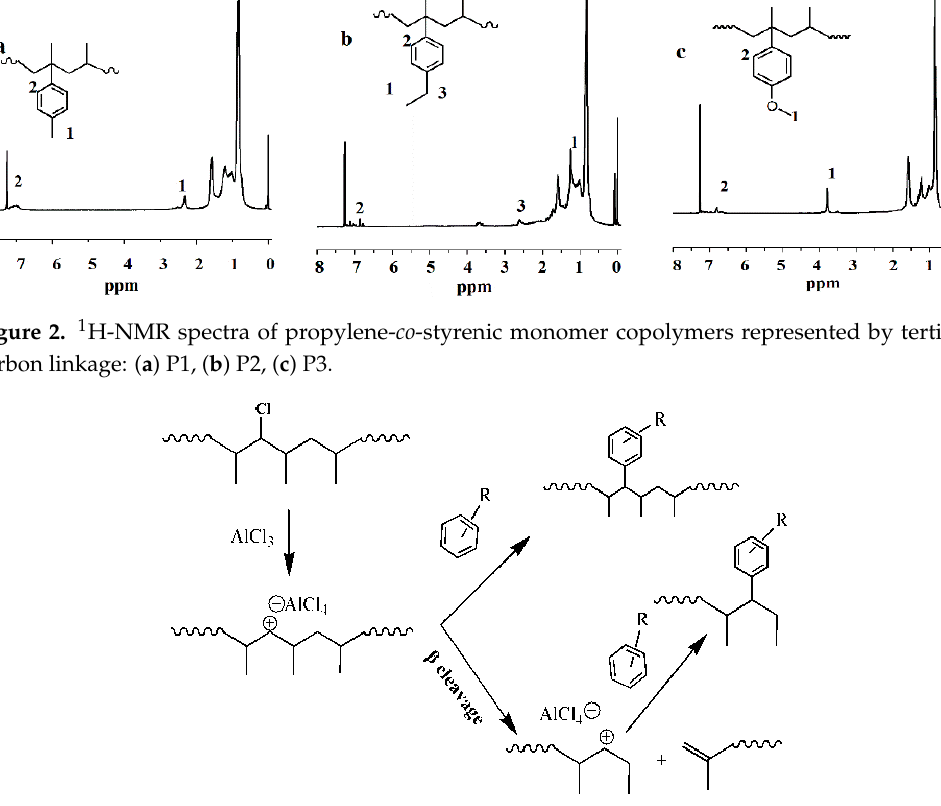
Scheme 1. Friedel–Crafts alkylation and chain scission reaction mechanisms.